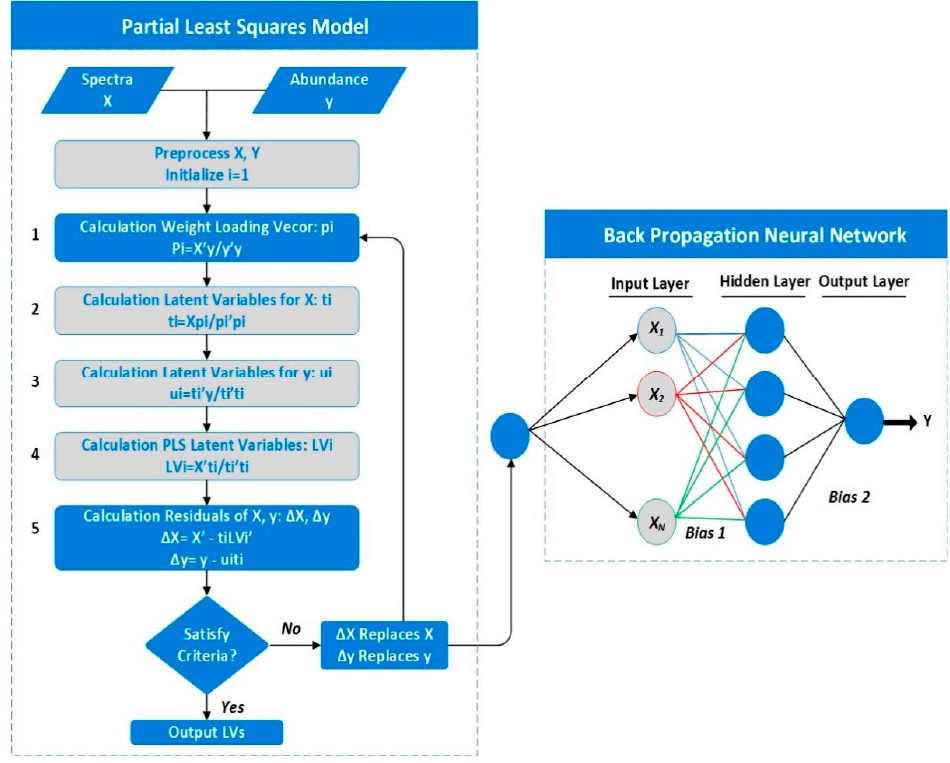
Figure 3. The proposed RBFNN is optimized by and Partial Least − Squares Regression model.